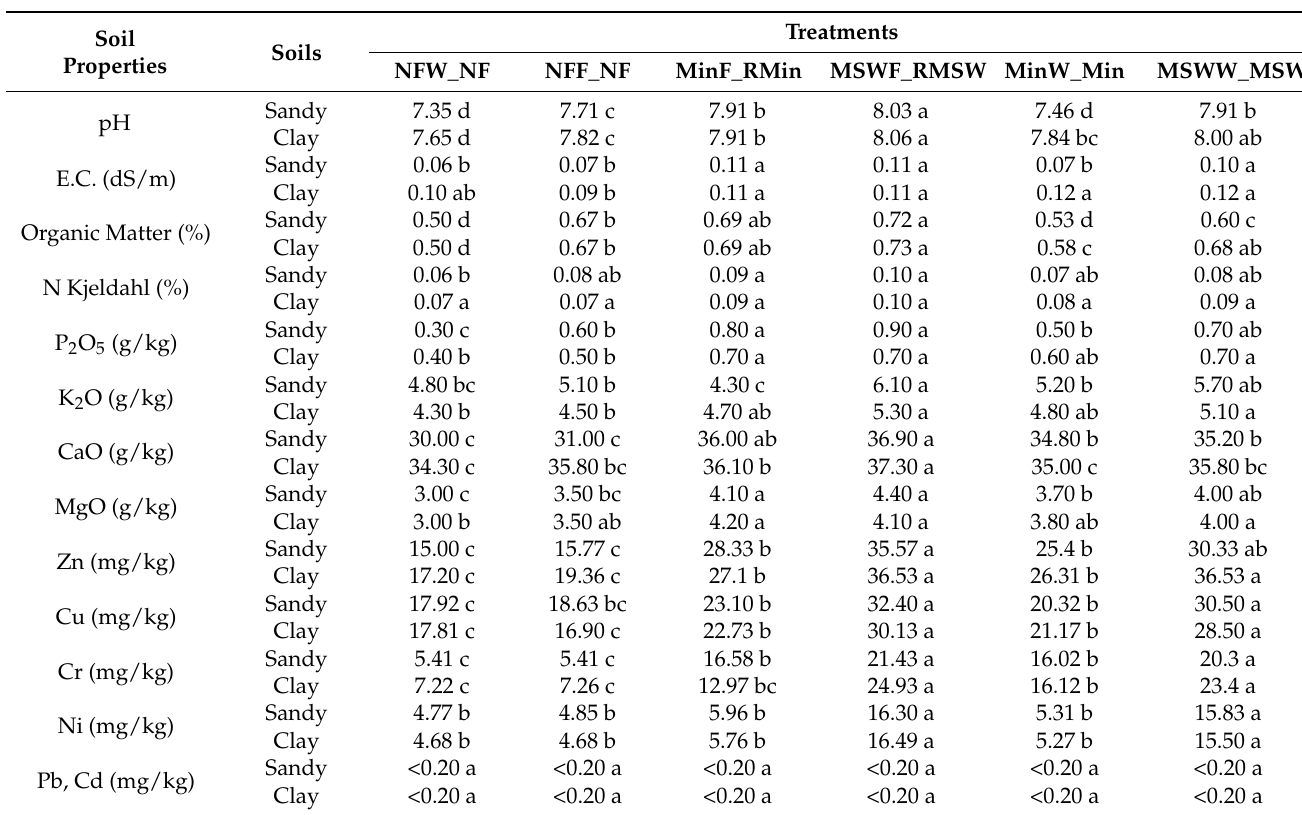
Table 2. Soil chemical properties of the different nutrient availability treatments at the beginning of the experiment. Different letters represent significant differences among treatments ( p <